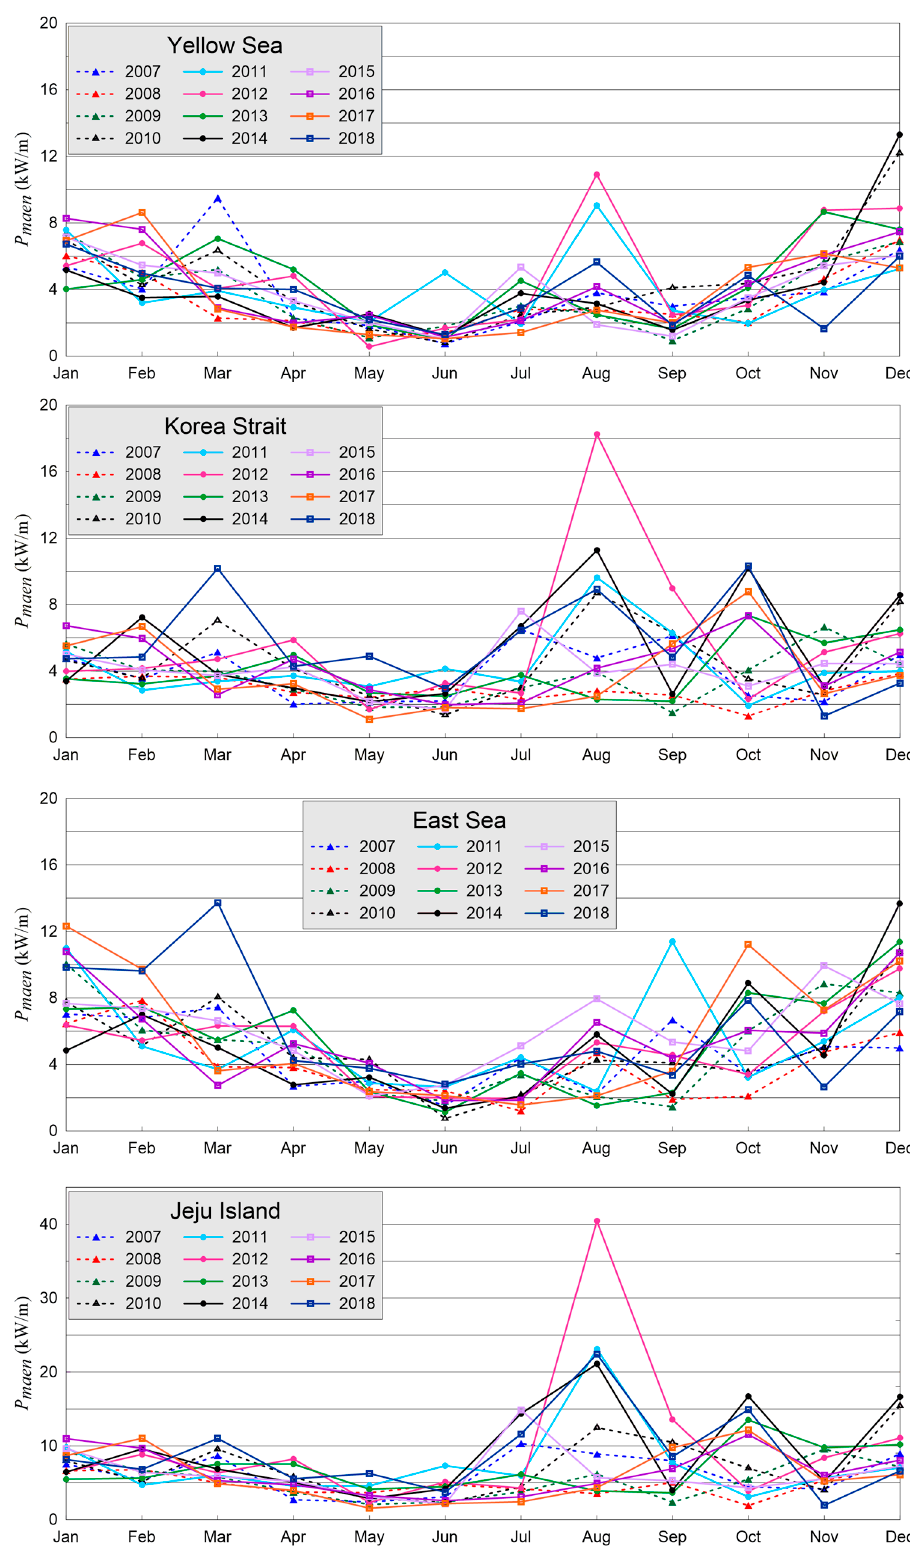
Figure 9. Time series of monthly overall predicted wave power around the Korean Peninsula (Yellow Sea, Korea Strait, East Sea, Jeju Island) over 2007–2018. Note that the maximum value in the Y-axis for Jeju Island is 40.